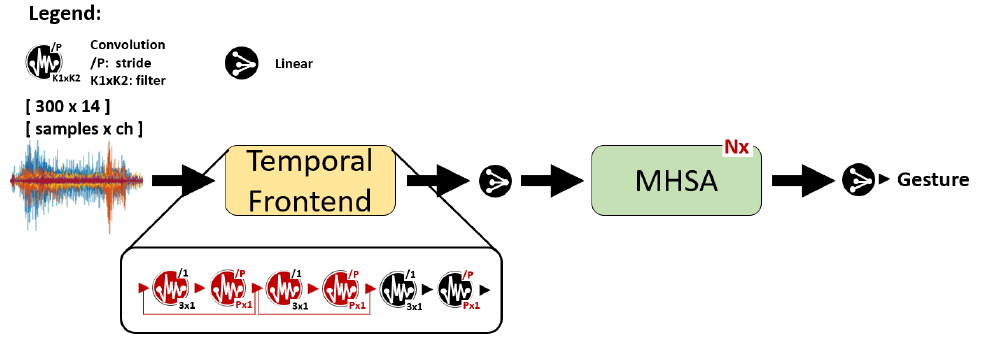
Figure 3. Architecture template of